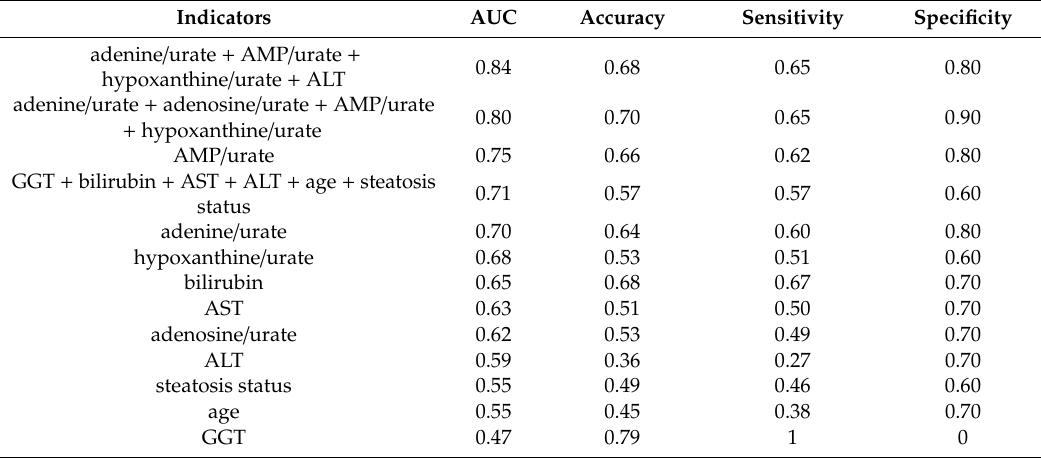
Table 2. ROC analysis for five annotated metabolites and five donor clinical parameters at pre-transplant for the prediction of EGF.